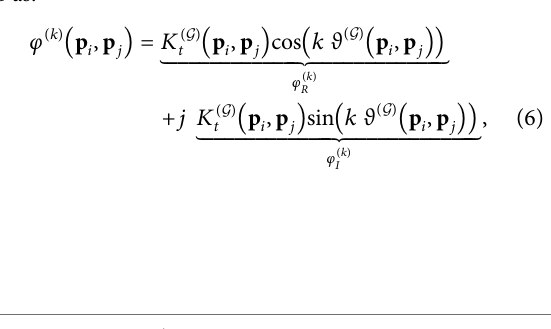
Frontiers in Signal Processing |